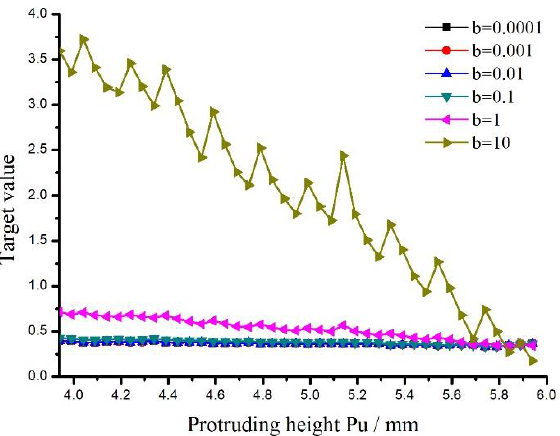
Figure 12. The target value when the weight coefficient b is from 0.0001 to 10.